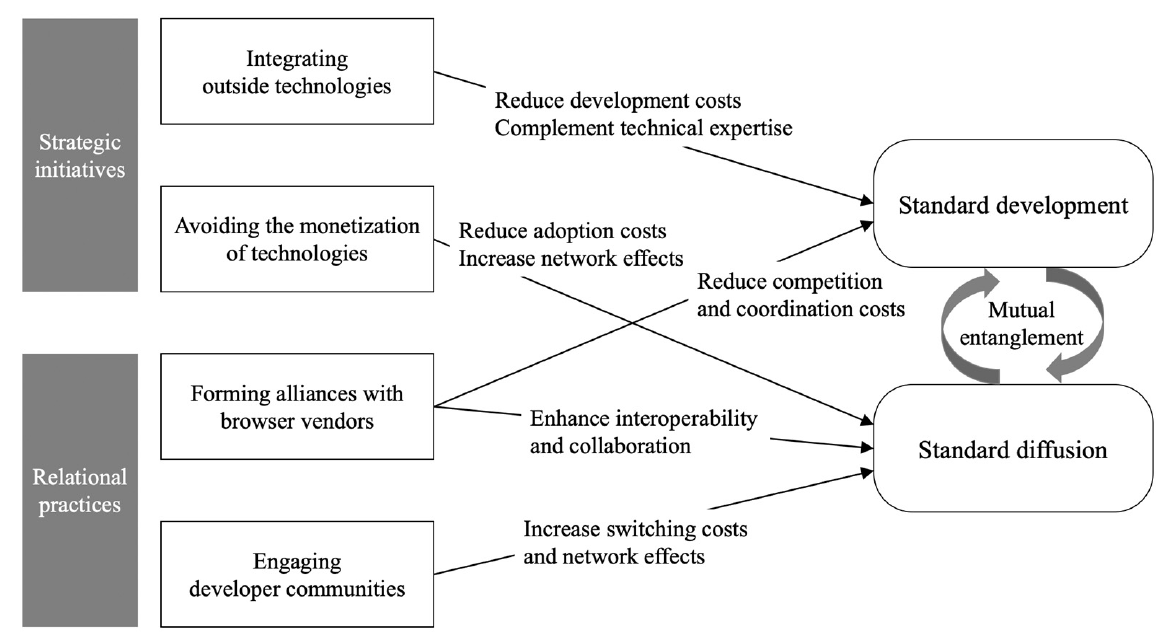
Figure 1. Mechanisms behind Google’s standard development and diffusion strategies.